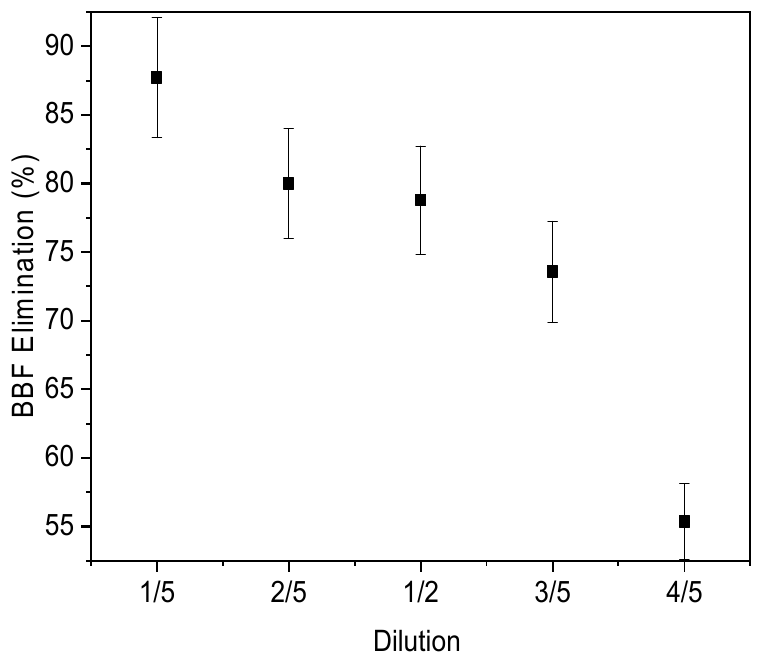
Figure 8. Evaluation of the effect of wastewater dilution on dye removal: wastewater pH = 5; doped wastewater pH = 7; Δ P = 5 bar; treatment time = 15 min.